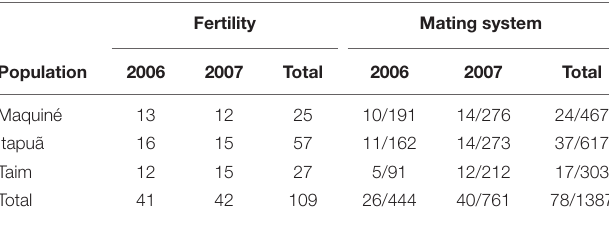
TABLE 2 | Sample sizes per population and year for fertility (adult plants) and mating system analysis (adult plants/progenies) in the three studied populations of Vriesea